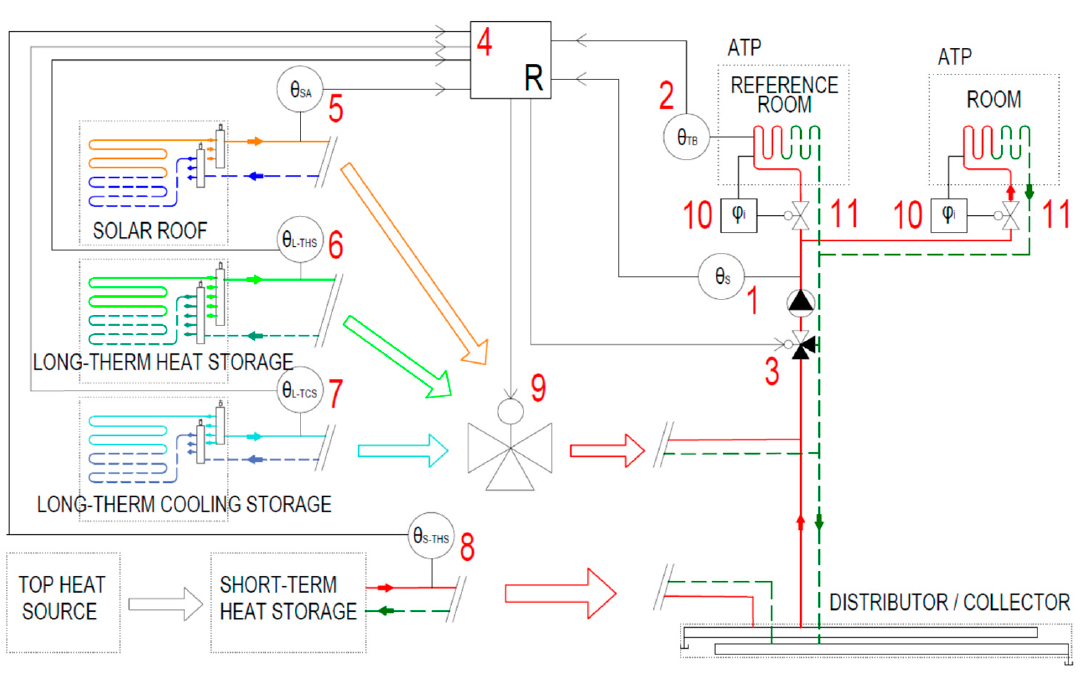
Figure 10. The fundamentals of temperature regulation at the thermal barrier level while using active thermal protection. 1—heating water supply temperature sensor; 2—thermal barrier temperature sensor; 3—three-way mixing valve with actuator; 4—controller; 5—output solar absorber temperature sensor; 6—heating water temperature sensor at the long-term heat storage tank output; 7—cooling water temperature sensor at the long-term heat storage tank output; 8—heating water temperature sensor at the short-term heat storage tank output; 9—three-way diverter valve with actuator; 10—contact dew point sensor; 11—two-way control valve with actuator. Figure 11 is a block diagram of the thermal barrier level temperature control system solution. The thermal barrier is built as a two-pipe system with switching between winter and summer operations. For each operation, the desired temperature value is set